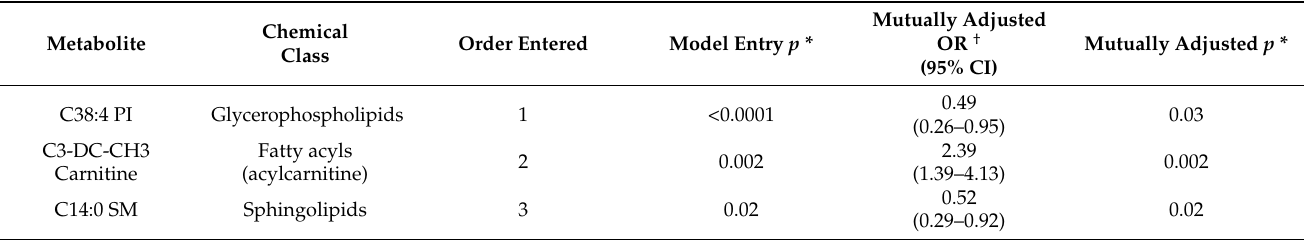
Table 3. Odds ratios (ORs) and 95% confidence intervals (CIs) for renal cell carcinoma when compar- ing the 90th with the 10th percentile levels of metabolites in forward selection models.